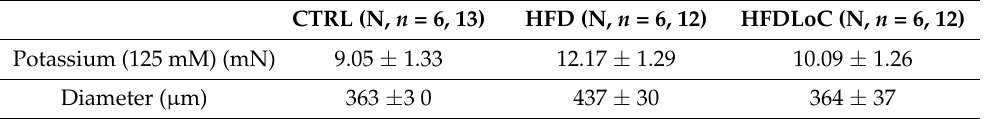
Table 2. Maximal potassium-induced contraction and calculated diameter of artery segments in- cluded in myograph studies. Data are presented as means ± SEM.